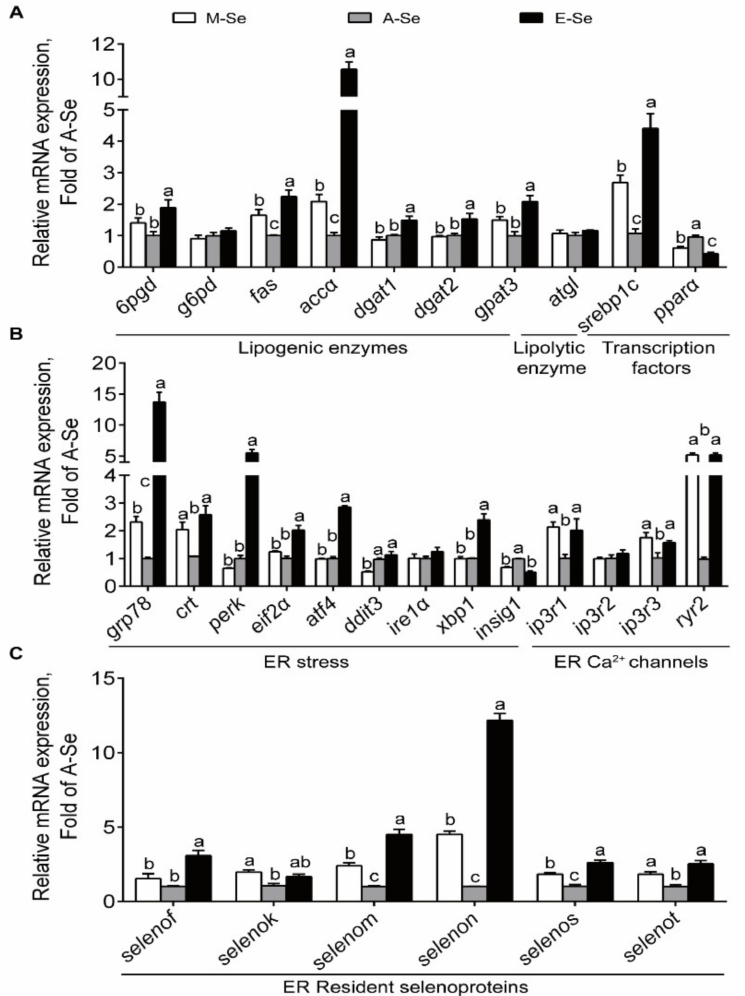
Figure 5. Relative mRNA levels of lipid metabolism ( A ), ER stress and ER Ca 2+ channels ( B ), related genes and selenoproteins ( C ) in the AI of yellow catfish fed diets varying in Se level for 12 wk. Values are means ± SEMs, n = 3 (replicates of 3 fish). Labeled means without a common letter differ, p < 0.05 (one-factor ANOVA, Duncan post hoc